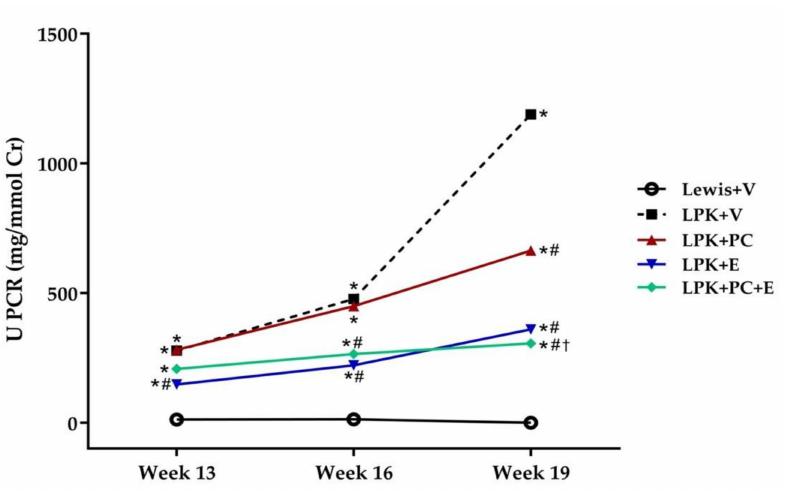
Figure 2. Effect of delayed paricalcitol treatment on the progression of proteinuria in LPK rats.